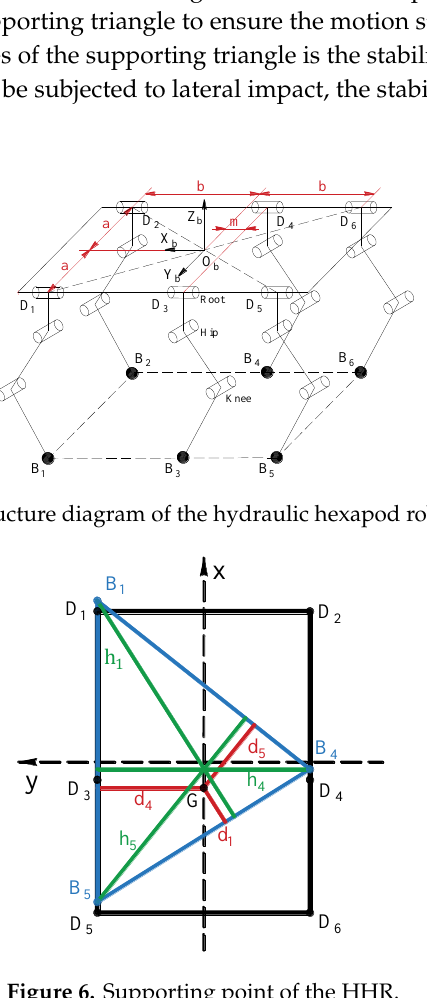
Figure 6. Supporting point of the HHR.